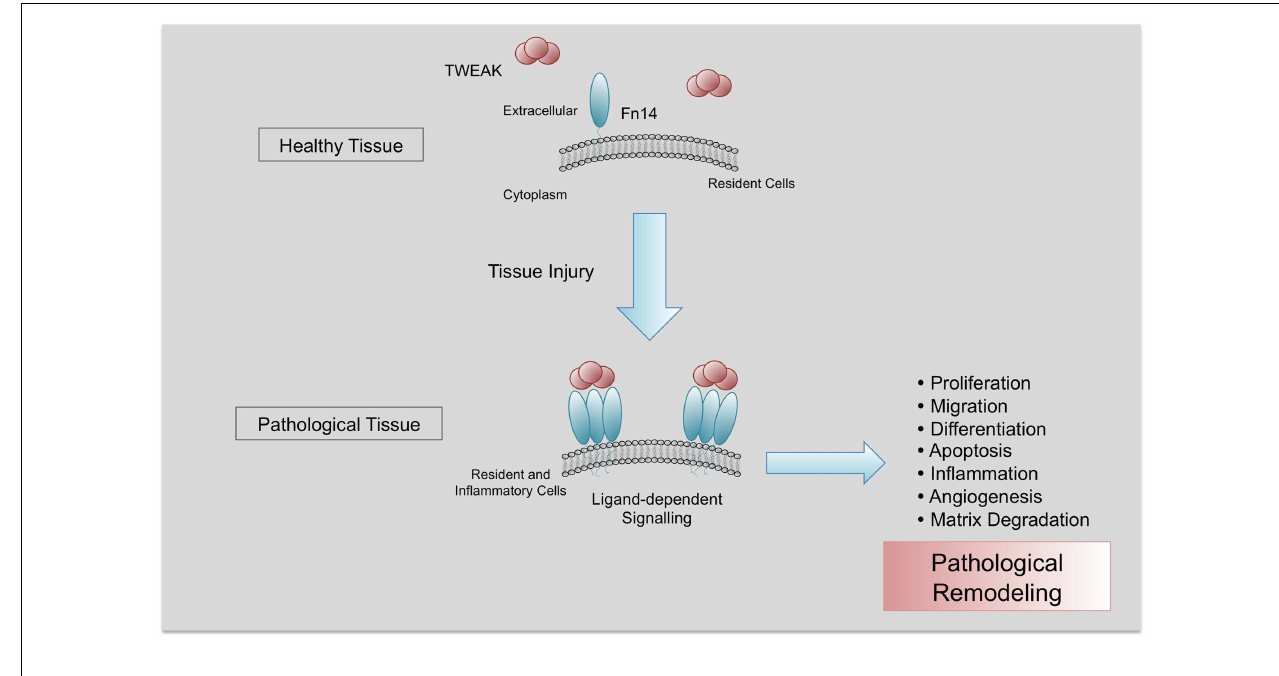
chronic injury,TWEAK/Fn14 interaction participates in pathological tissue remodeling, promoting proliferation, migration, differentiation, apoptosis, inflammation, angiogenesis, and matrix